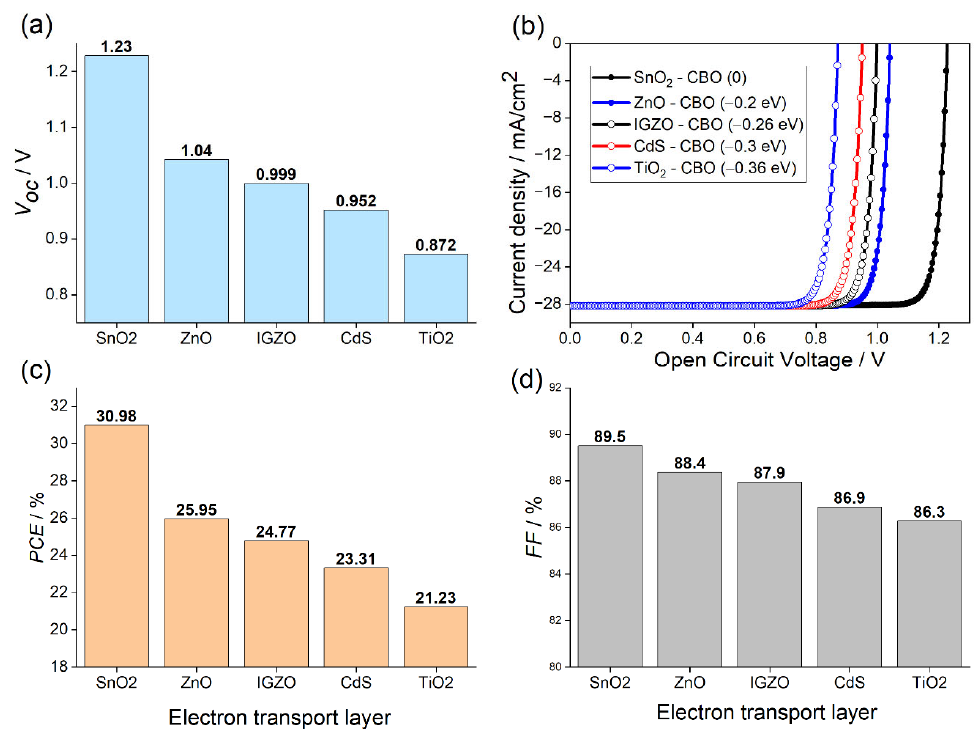
Figure 2. Variation in ( a ) V oc , ( b ) J − V characteristics, ( c ) PCE , and ( d ) FF for different ETL materials simulated in PSC.